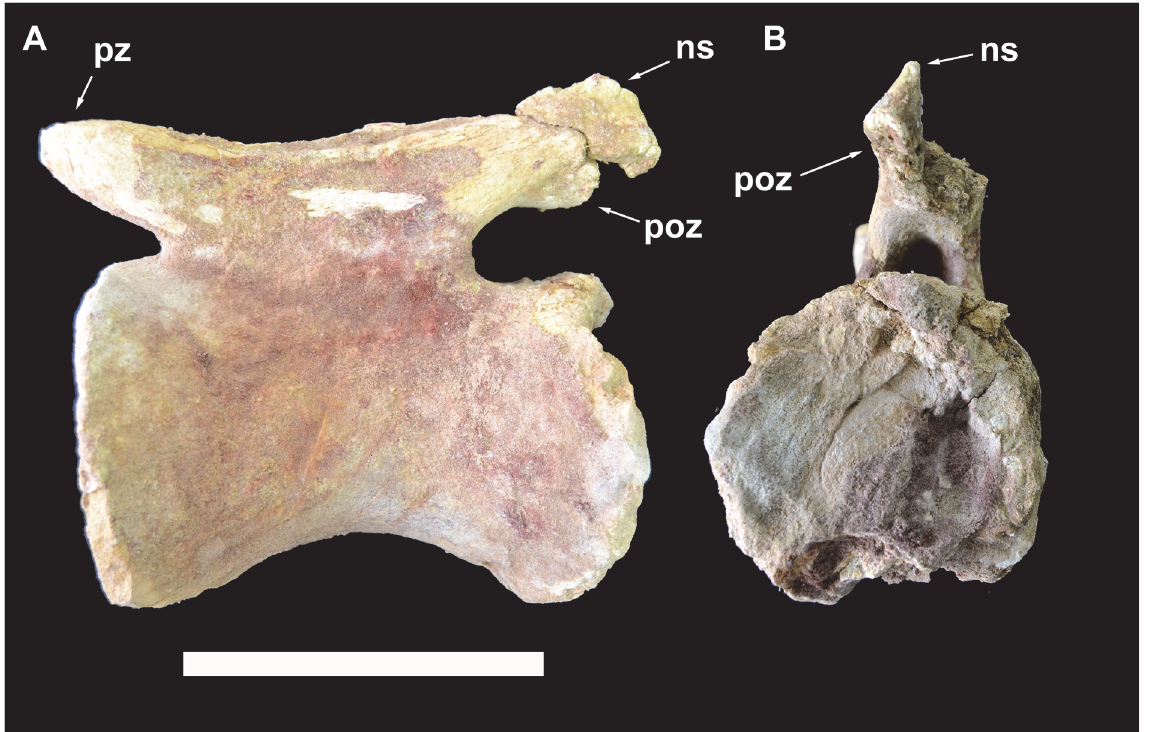
Fig 18. Caudal vertebra 17 of Tataouinea hannibalis . Vertebra in left lateral (A) and distal (B) views. Scale bar: 10 cm. Abbreviations: ns, neural spine; poz, postzygapophysis; pz,